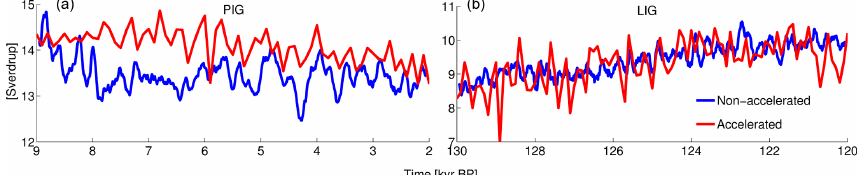
Figure 11. Temporal evolution of the AMOC (given as the maximum of the North Atlantic overturning stream function) during both the interglacials for both non-accelerated (blue) and accelerated (red) simulations. All plots were created using the decadal mean values (referring to model years). In addition, a 10-point running average was applied to the decadal mean values of the non-accelerated simulations.